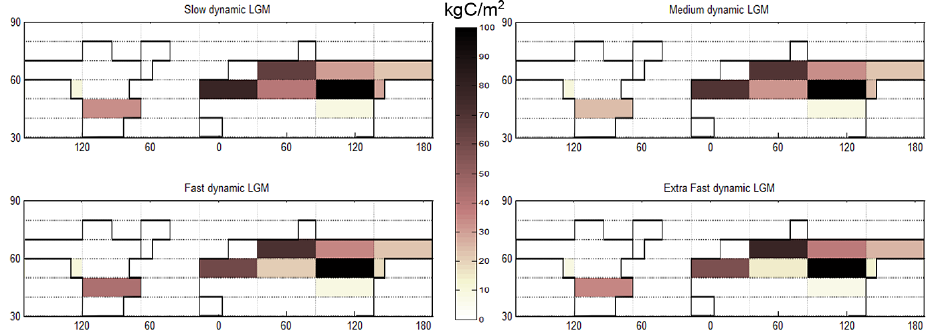
Figure 18. Modelled LGM(eq) SOCC (kgCm − 2 ) in permafrost soils for top 100cm.